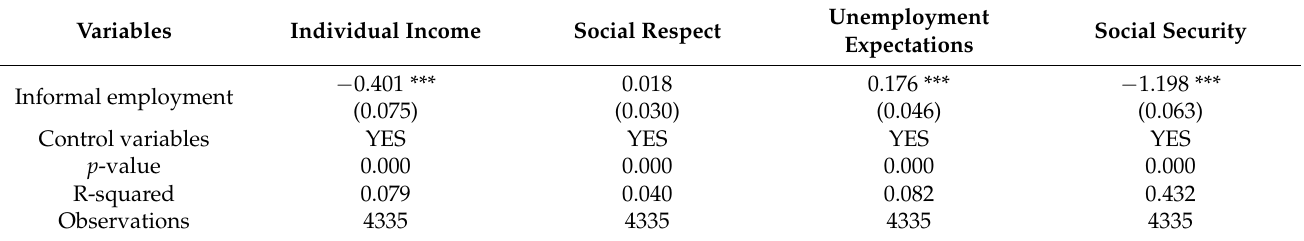
Table 4. Channels of informal employment effect on residents’ happiness.